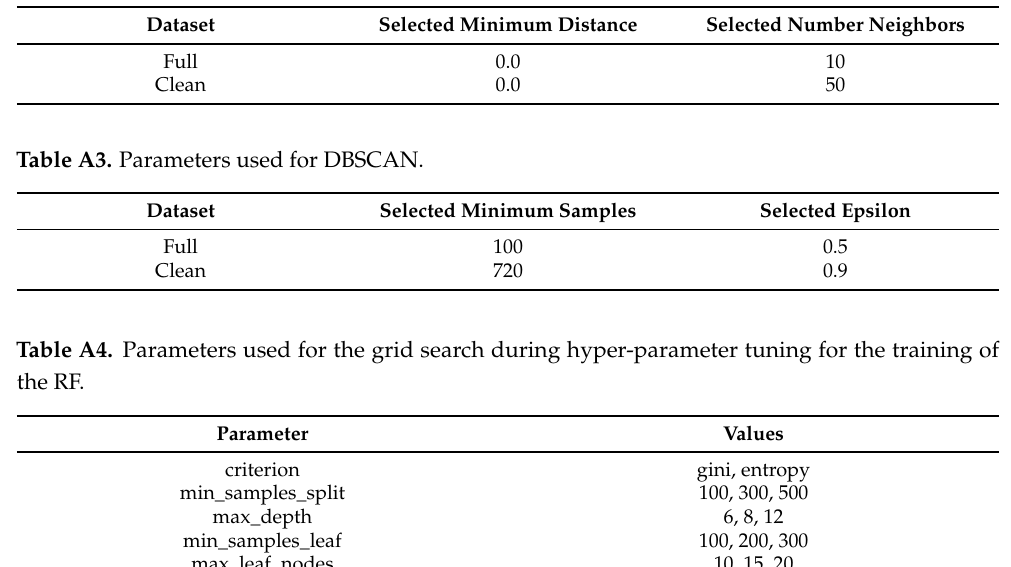
Table A2. Parameters used for UMAP dimension reduction.